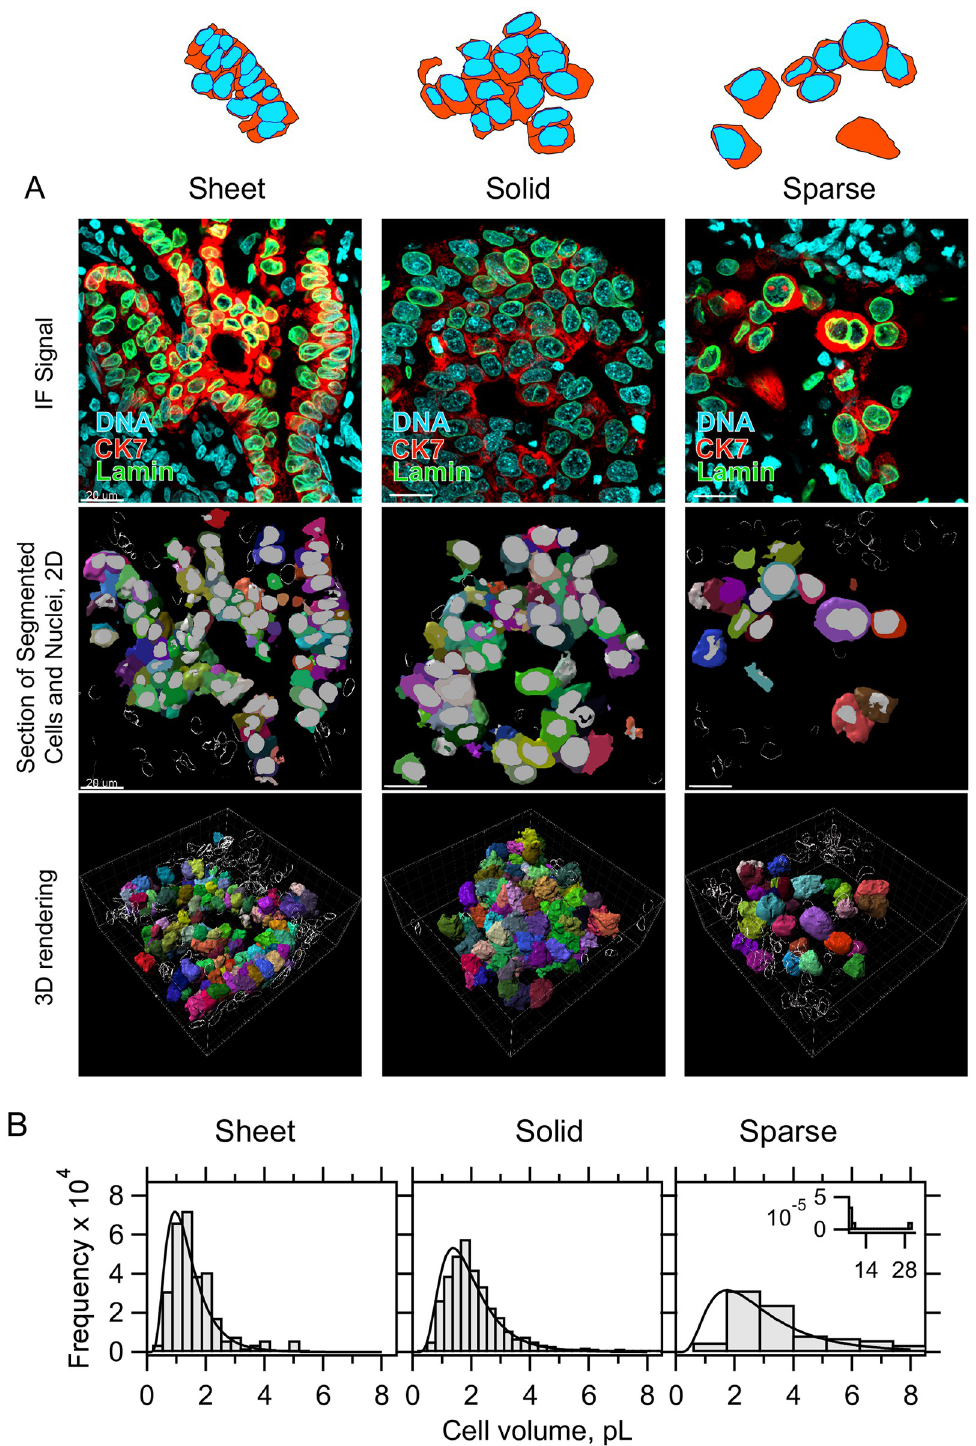
Fig 4. Tumor tissue organization correlates to the extent of cell size dysregulation. A, Schematic: sheet, solid, and sparse patterns of tissue organization describe most lung tumor data. Top: representative IF signal for three types, immunostained for CK7 (red) and Lamin A+C (green), observed in both EGFR+ and KRAS+ genotypes, EGFR+ patients shown. middle: Renderings of 2D segmentations; nuclei (gray) and cell surfaces (rainbow), Scale bars, 20 μ m. bottom: rendering of 3D segmentations, with stromal controls shown as bubble depictions. White box shows perspective